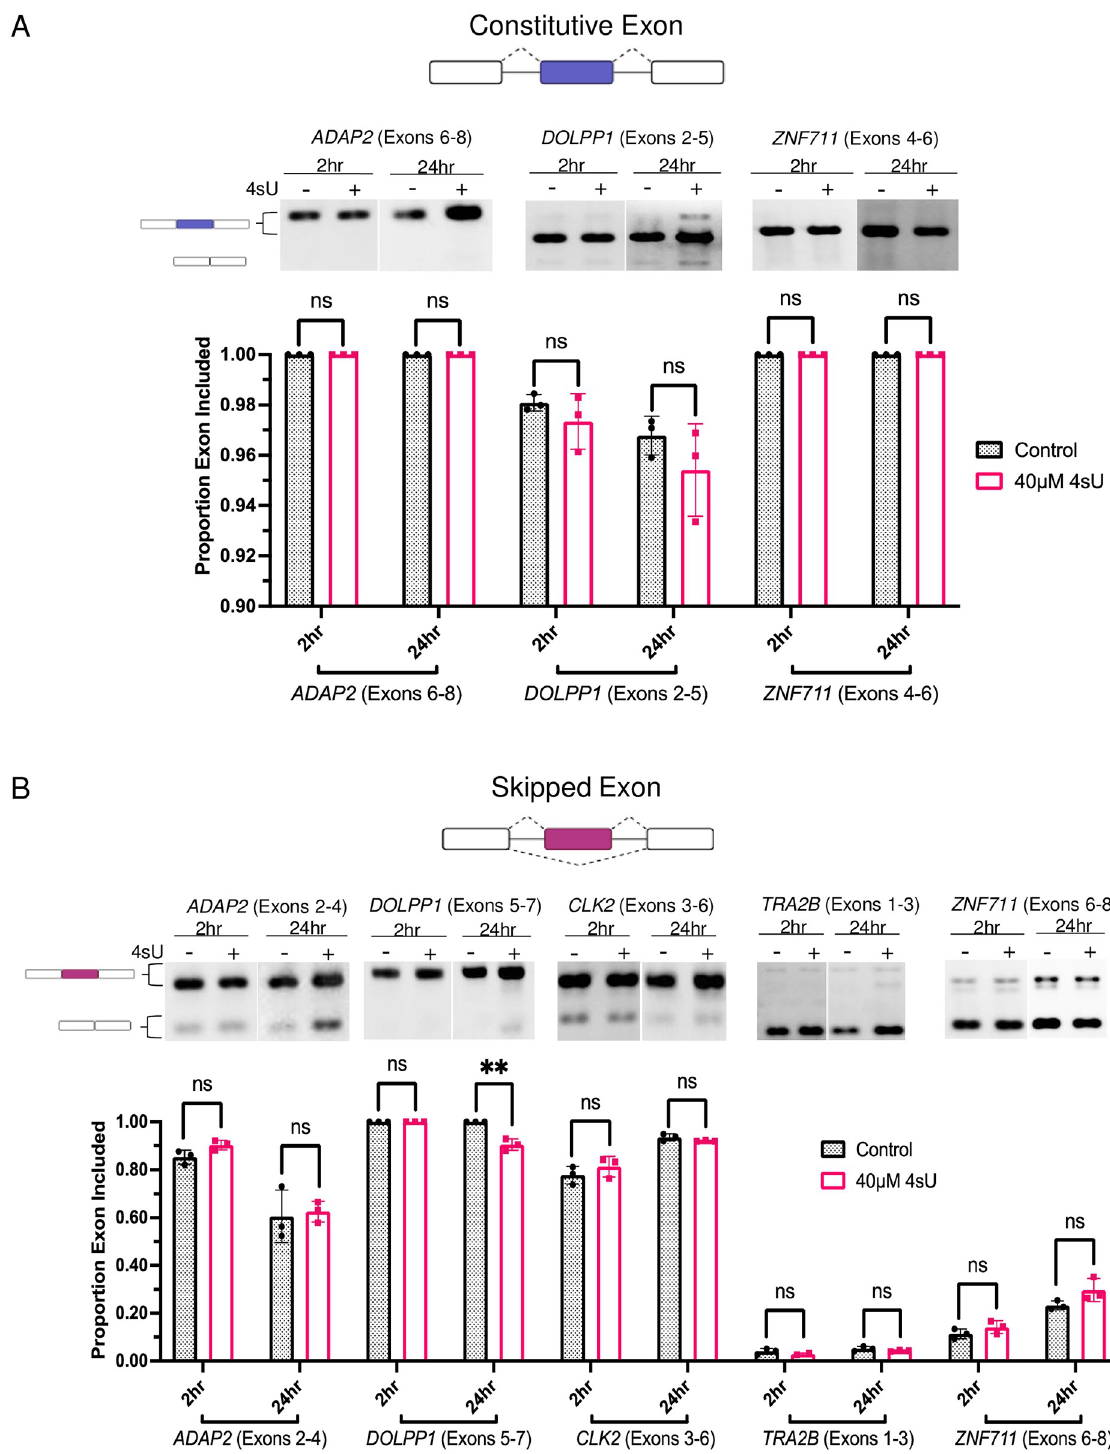
Fig 4. Splicing behavior in cell culture in the presence of 4sU. PCR analysis of (A) constitutive exons within the genes ADAP2 , DOLPP1 , and ZNF711 and (B) alternatively included exons in genes ADAP2 , CLK2 , TRA2B , ZNF711 , and DOLPP1 . Alternative exon inclusion in DOLPP1 (‘ �� ’, P = 0.0024). ‘ns’ indicates no statistically significant difference P > 0.05). The cartoon to the left of each image indicates exon inclusion or exclusion. cDNA from biological triplicates were analyzed after 2 and 24 hours of 4sU incubation.